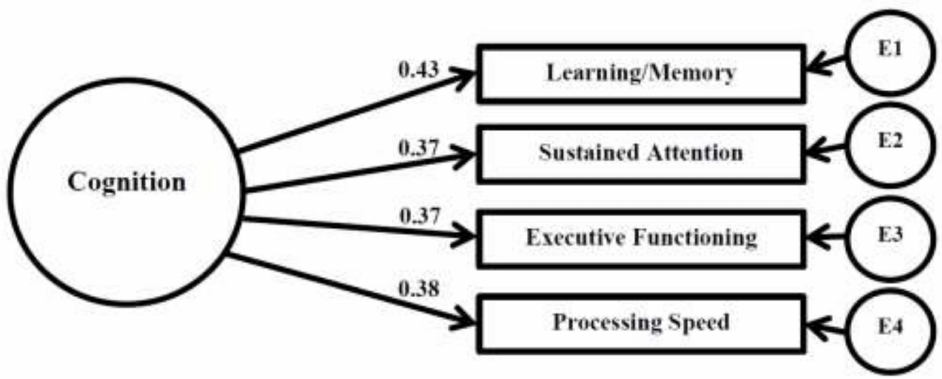
Figure 2. Confirmatory Factor Analysis: Cognition; * Significant ( p ≤ 0.05); E =